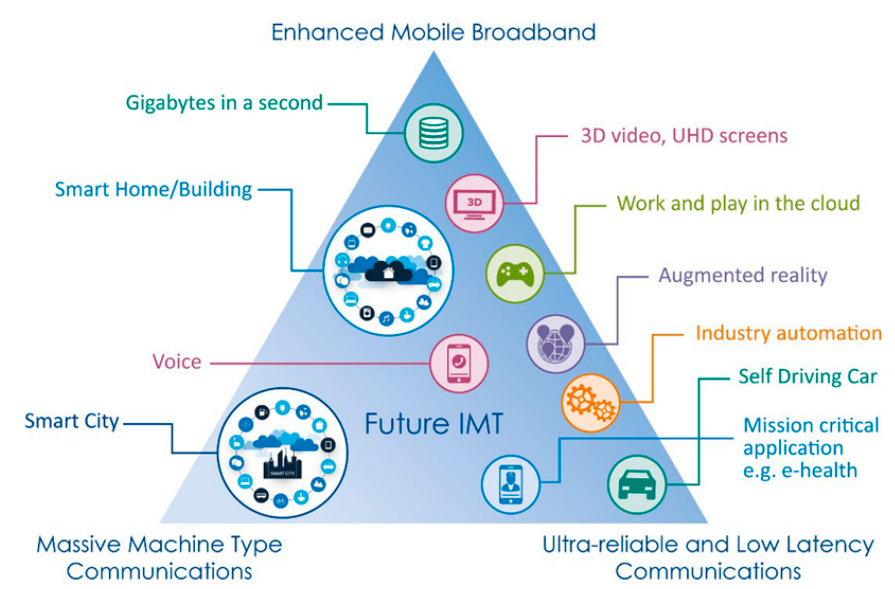
Figure 6. Three major application scenarios for 5G in 2015 defined by ITU [13].